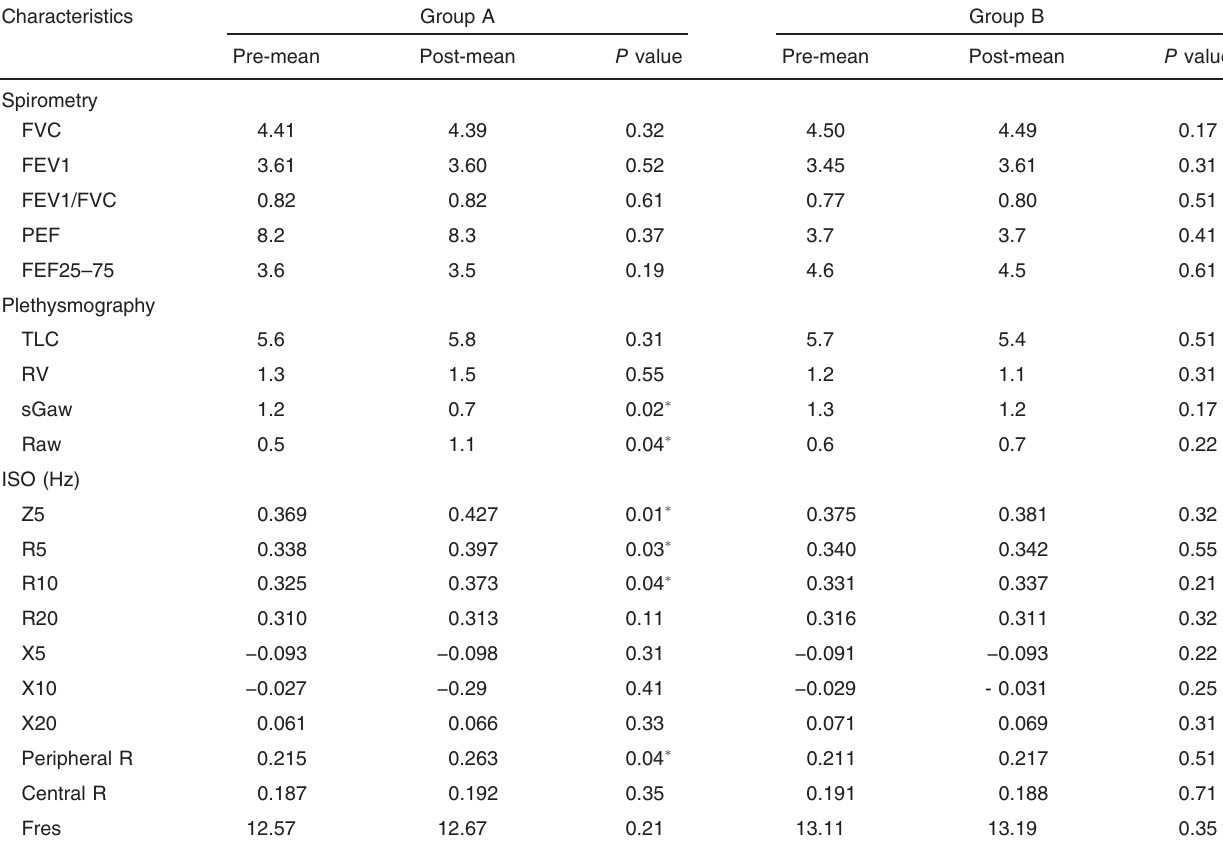
Table 2 Changes in pulmonary mechanics before and after vaping of an e-cigarette